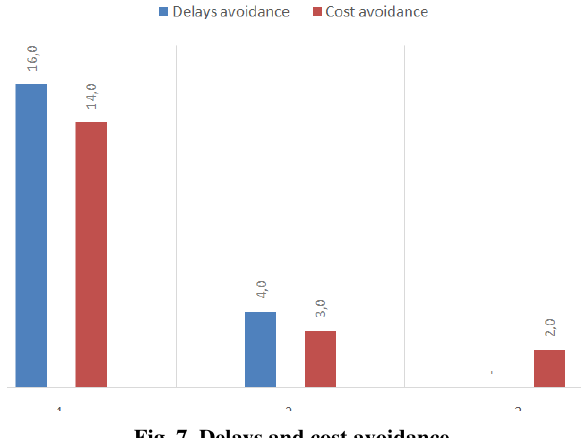
Fig. 7. Delays and cost avoidance